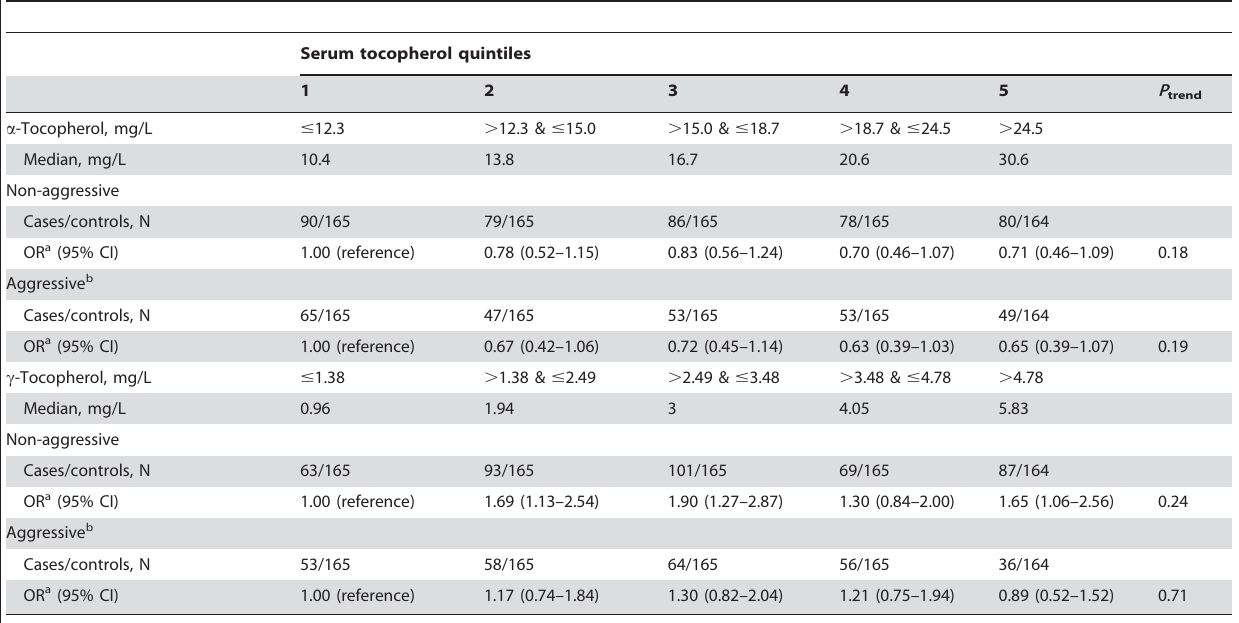
Table 4. Association between baseline serum a -tocopherol and c -tocopherol and risk of prostate cancer, stratified by disease stage and grade, PLCO Study.